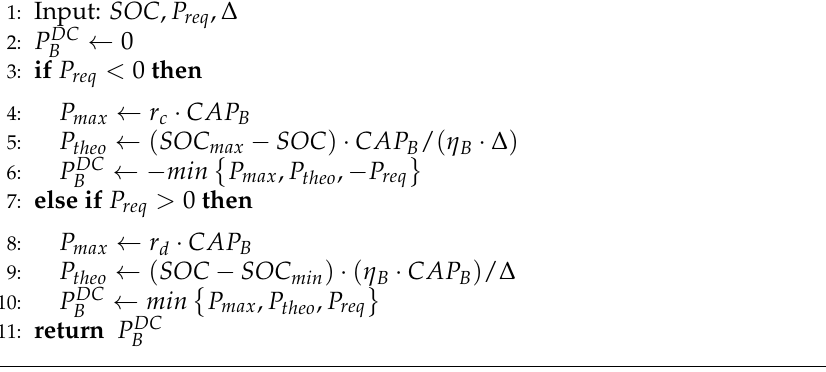
Figure 3. Algorithm of getBatPower ( SOC , P req , ∆ ) .